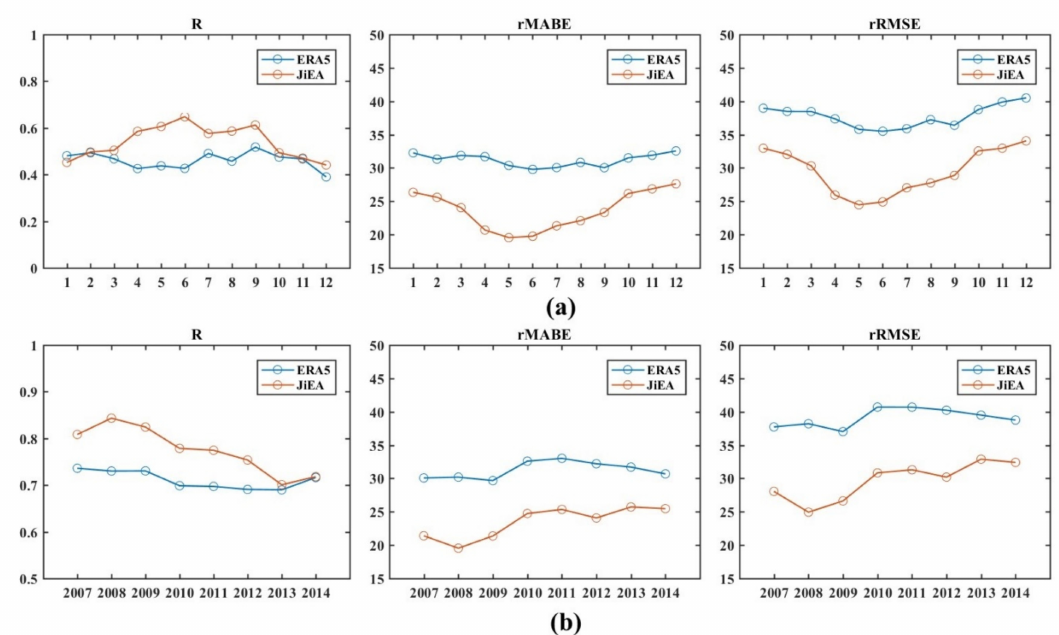
Figure 4. Temporal variation of R, rMABE and rRMSE: ( a ) results among di ff erent months; ( b ) results among di ff erent years. We illustrate the mean value of all stations at daily mean